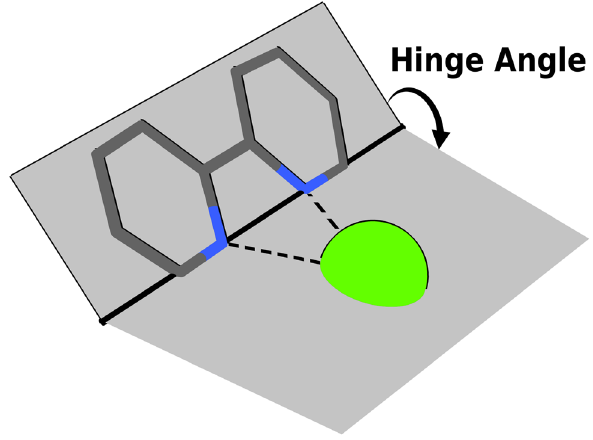
Figure 4. Sample illustration of a hinge angle for a bidentate ligand in a complex.